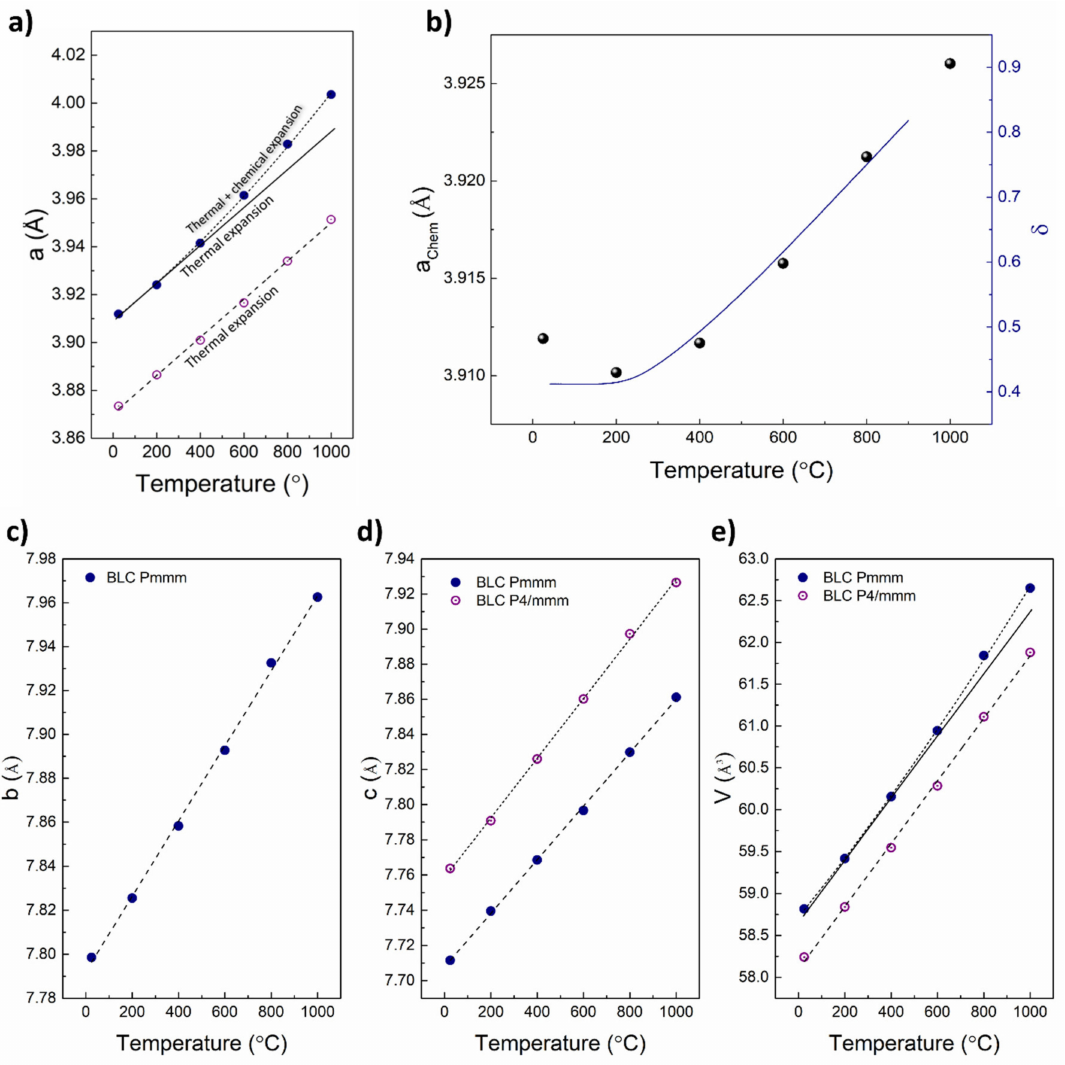
Figure 7. Temperature evolution of lattice parameters of orthorhombic and tetragonal BLC ( a , c – e ). Correlation between change in a parameter, resulting from chemical expansion, and the concentration of oxygen vacancies ( b